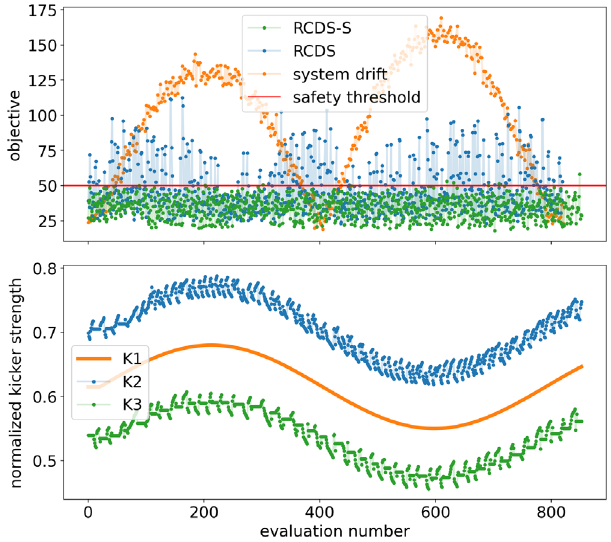
FIG. 11. RCDS-S on the kicker-bump matching experiment on the SPEAR3 storage ring, with a safety threshold of 50 μ m. Top plot: orange dots show the objective drift caused by the modulated kicker strength at the initial solution. Blue dots denote the optimization performance of the RCDS algorithm while green dots show the performance of RCDS-S. The red horizontal line shows the safety threshold. Bottom plot: orange curve shows the modulation on K1, and the other two dotted curves visualize the evolution history of the variables as they were tuned by